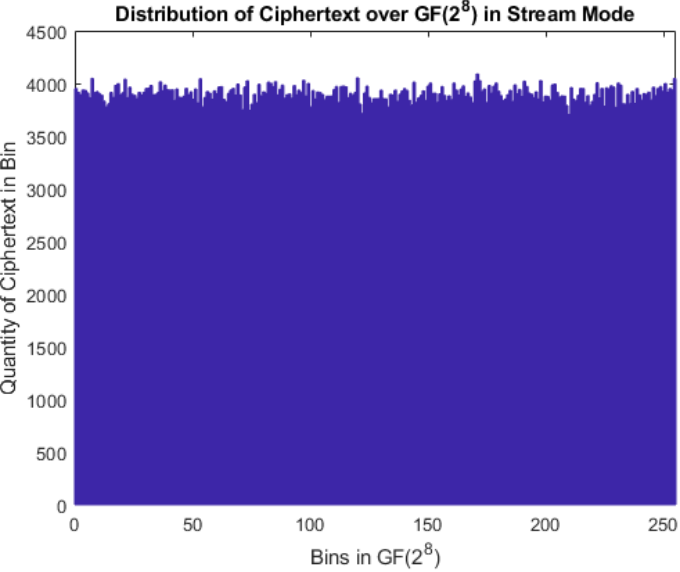
Figure 7. Distribution of ciphertext across GF(2 8 ) (Stream